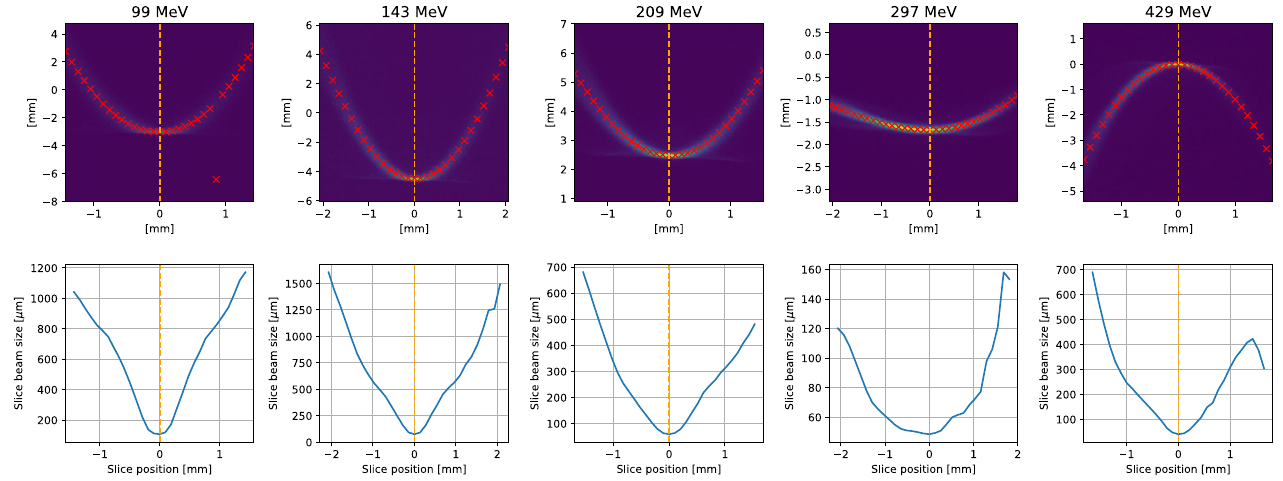
FIG. 6. Beam images (top) and corresponding slice beam sizes (bottom) for the 10 pC measurement and different energies. The beam is vertically streaked and horizontally dispersed, but to align the images with the slice beam size curves beneath, we have rotated the images such that the streaking direction appears as horizontal and the dispersive direction as vertical. The red crosses indicate the slice centroids. The core slice horizontal beam size is marked by the orange dashed